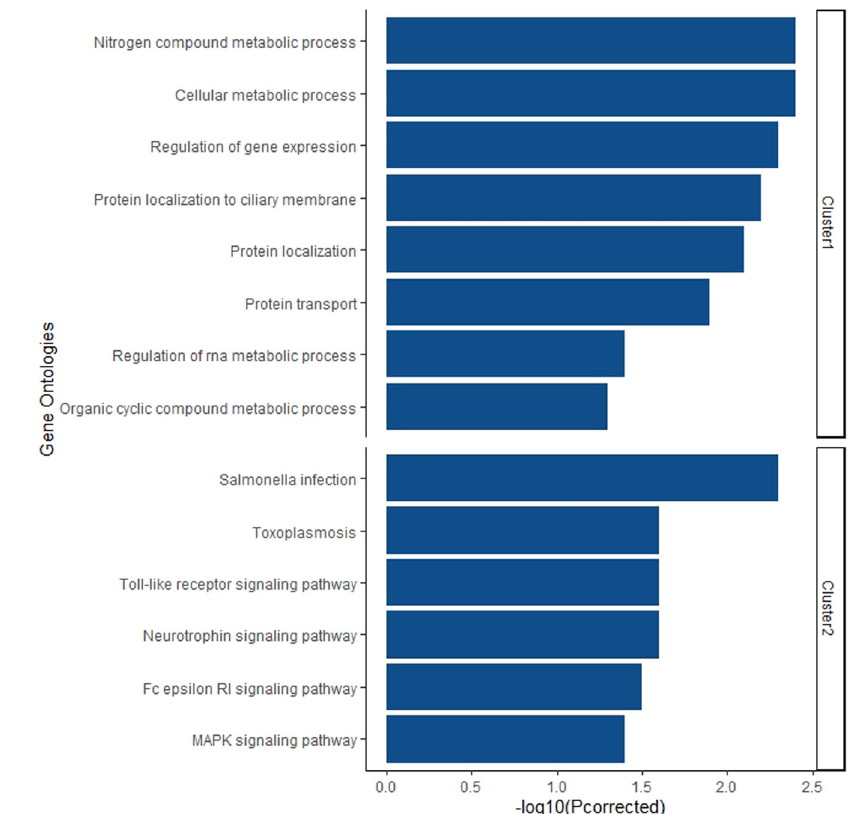
Fig. 2 Gene-set enrichment analysis (Gene Ontology Biological Process) of each Cluster. Only signi fi cant terms are shown (adjusted p -value <